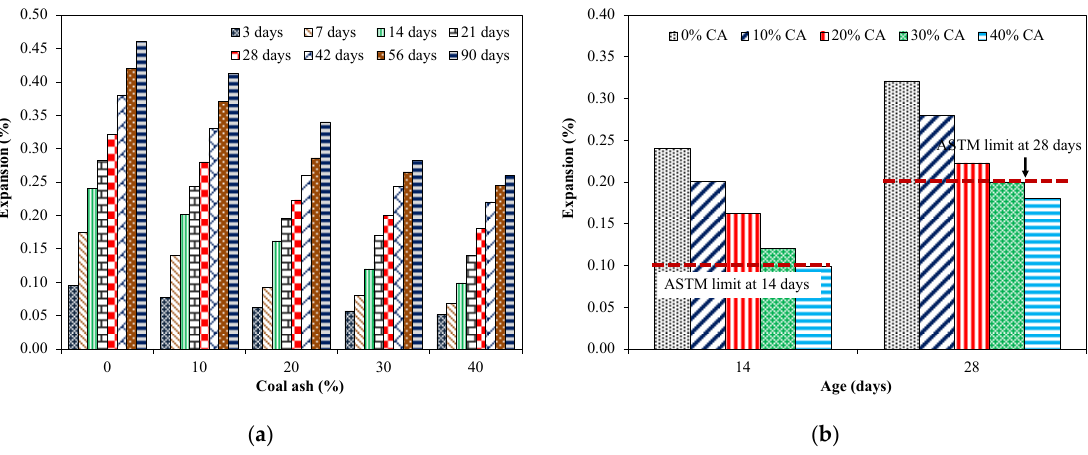
Figure 10. Expansion results for specimens exposed to ASR conditions: ( a ) specimens incorporating CA; ( b ) ASTM limits.